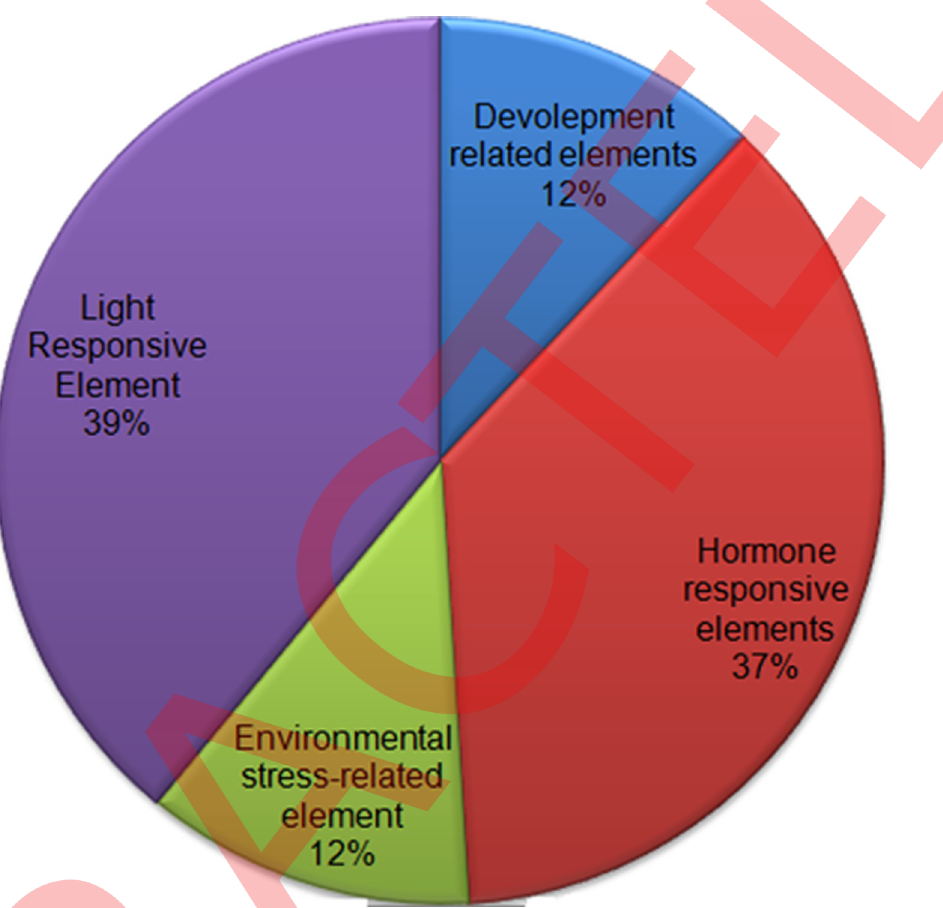
Fig 9. Cis-element analysis in the GmSS gene family. PlantCare were used to analyze the region 1500 bp upstream of each of the GmSS genes. The percentage of responsive elements, hormone responsive elements, environmental stress related elements, plant growth responsive elements and site binding responsive elements (except for TATA and CAAT binding sites) in all GmSS